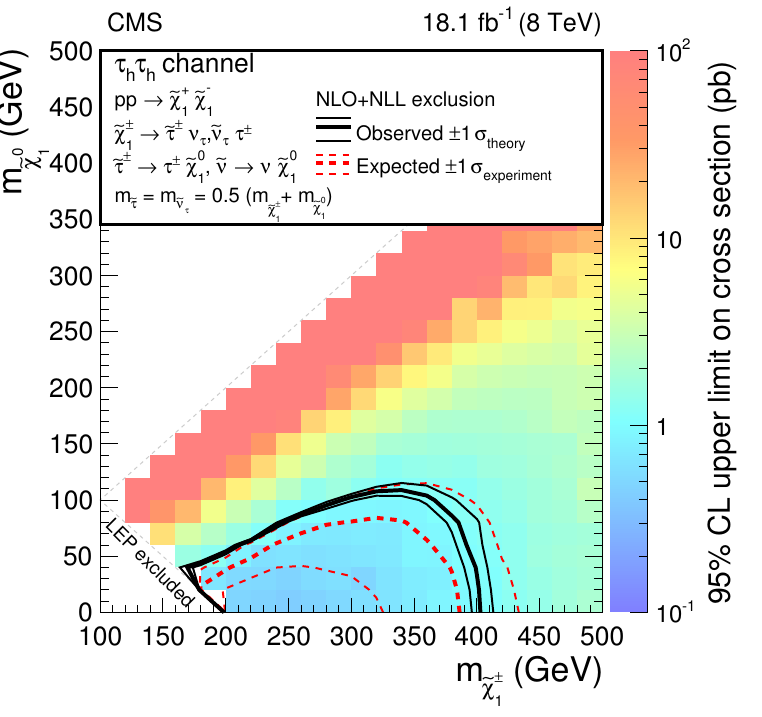
Figure 6 . Expected and observed exclusion regions in terms of simpli(cid:12)ed models in the (cid:28) channel. The conventions are the same as (cid:12)gure